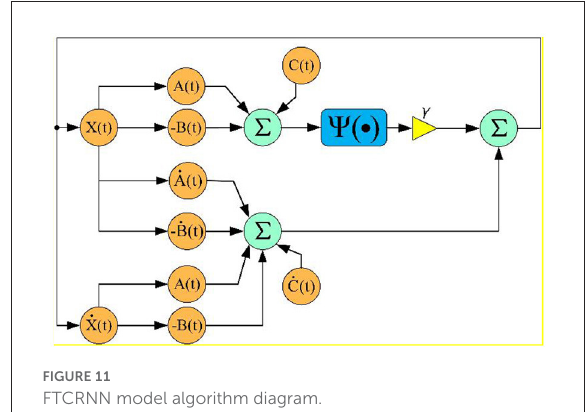
FIGURE11 FTCRNN model algorithm diagram.